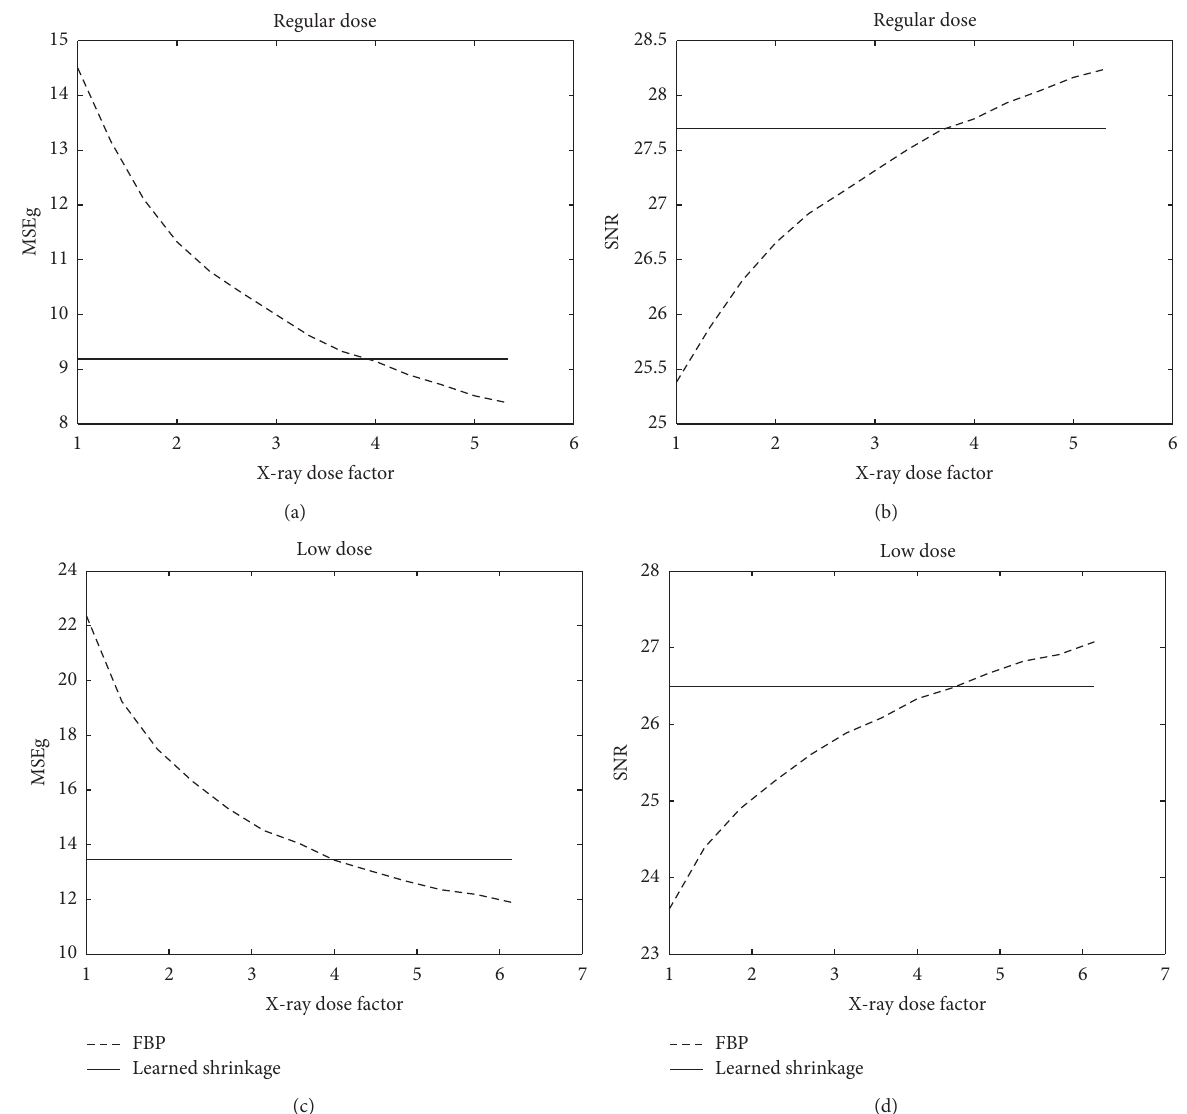
Figure 23: Effective dose reduction by the proposed method, with respect to the optimally tuned FBP algorithm. (a), (b) Regular X-ray dose. (c), (d) low X-ray dose. (a), (c) MSEg measure. (b), (d): SNR